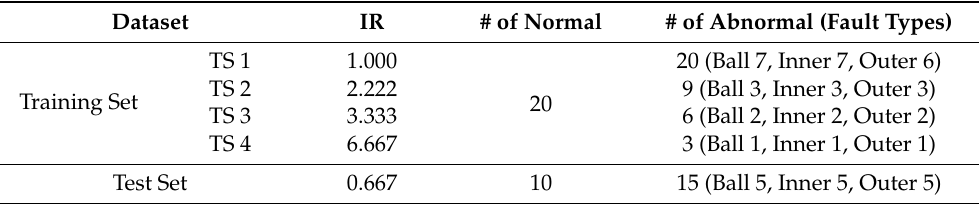
Table 1. Data set configuration according to the imbalance ratio (IR). MDC and MTS use only normal data for training, while binary classification methods use both normal and abnormal data. Dataset IR # of Normal # of Abnormal (Fault